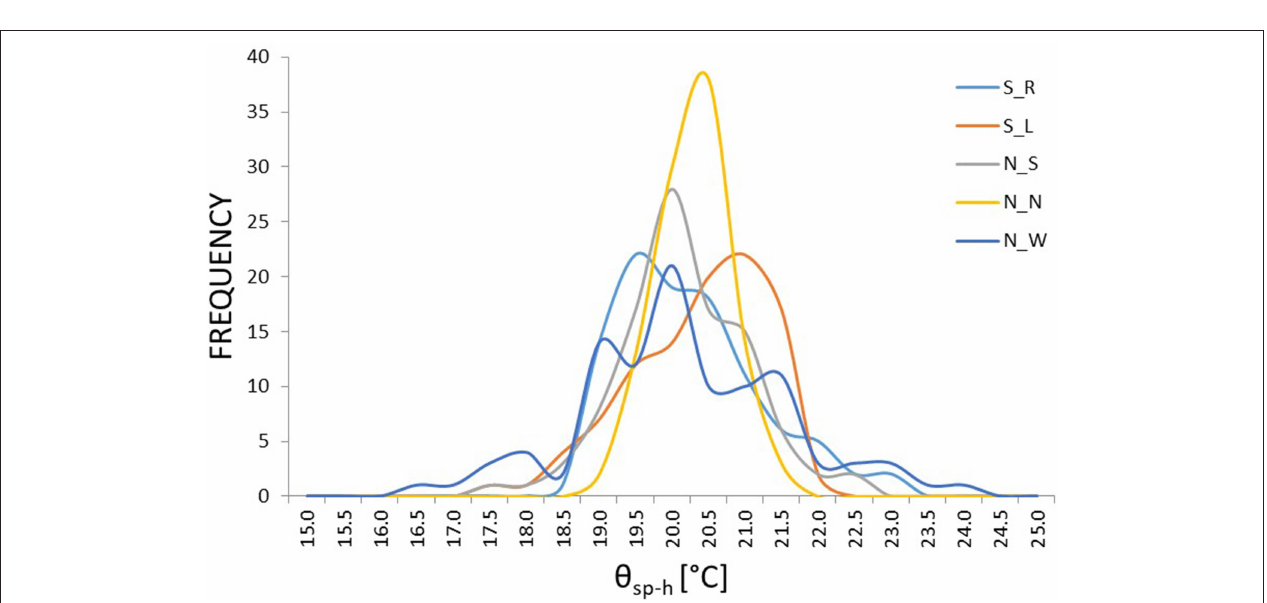
FIGURE 6 | Assumed heating temperature set-point distributions toward computation of annual heating demand (see Figure 5 ). Reproduced from Berger et al. (2020) with permission from C. Berger, E. Primo, D. Wolosiuk, V. Corrado, and A. Mahdavi.